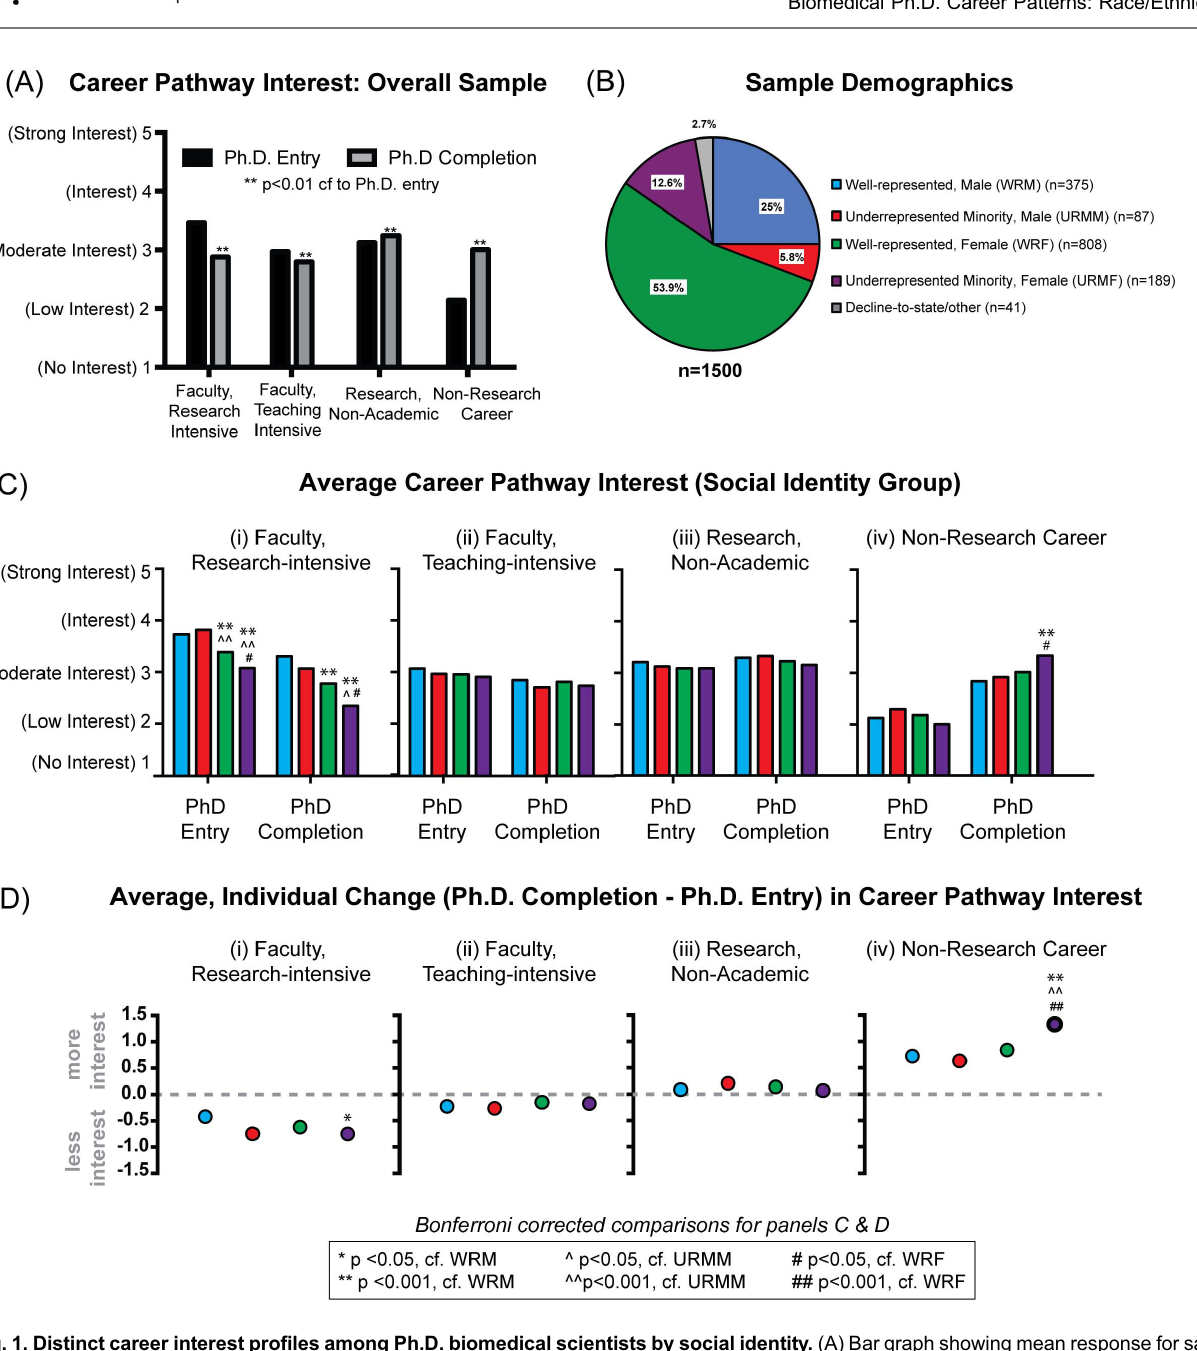
PLOS ONE | DOI:10.1371/journal.pone.0114736 December 10,